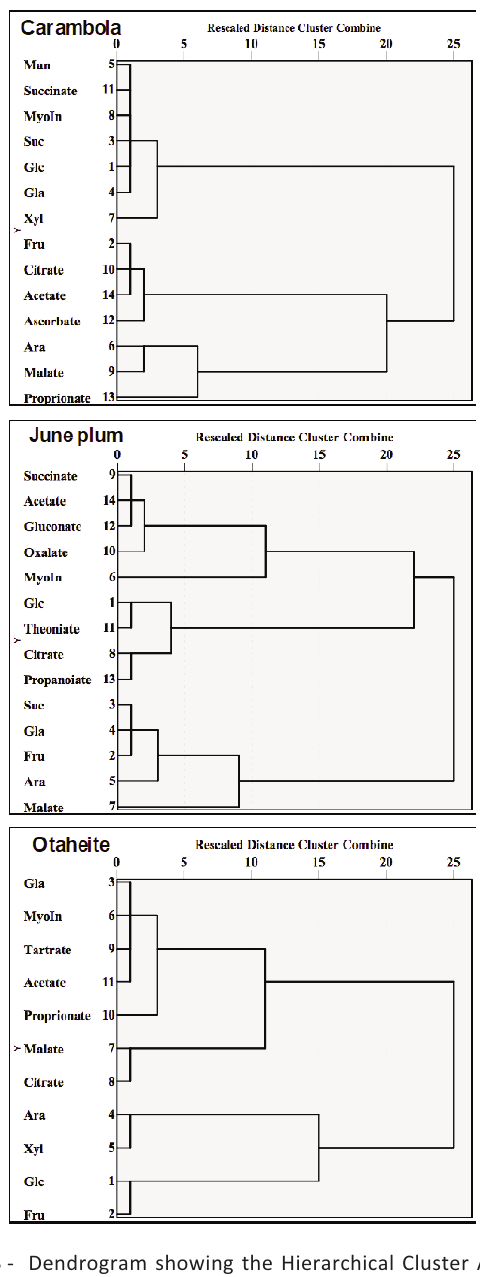
Fig. 3 ­ Dendrogram showing the Hierarchical Cluster Analysis (HCA) of profiled and identified metabolites in Carambola, June plum and Otaheite fruits through diffe­ rent development and ripening stages. To run HCA, data sets were normalised to reduce of the original data sets and hence allowing better clustering.